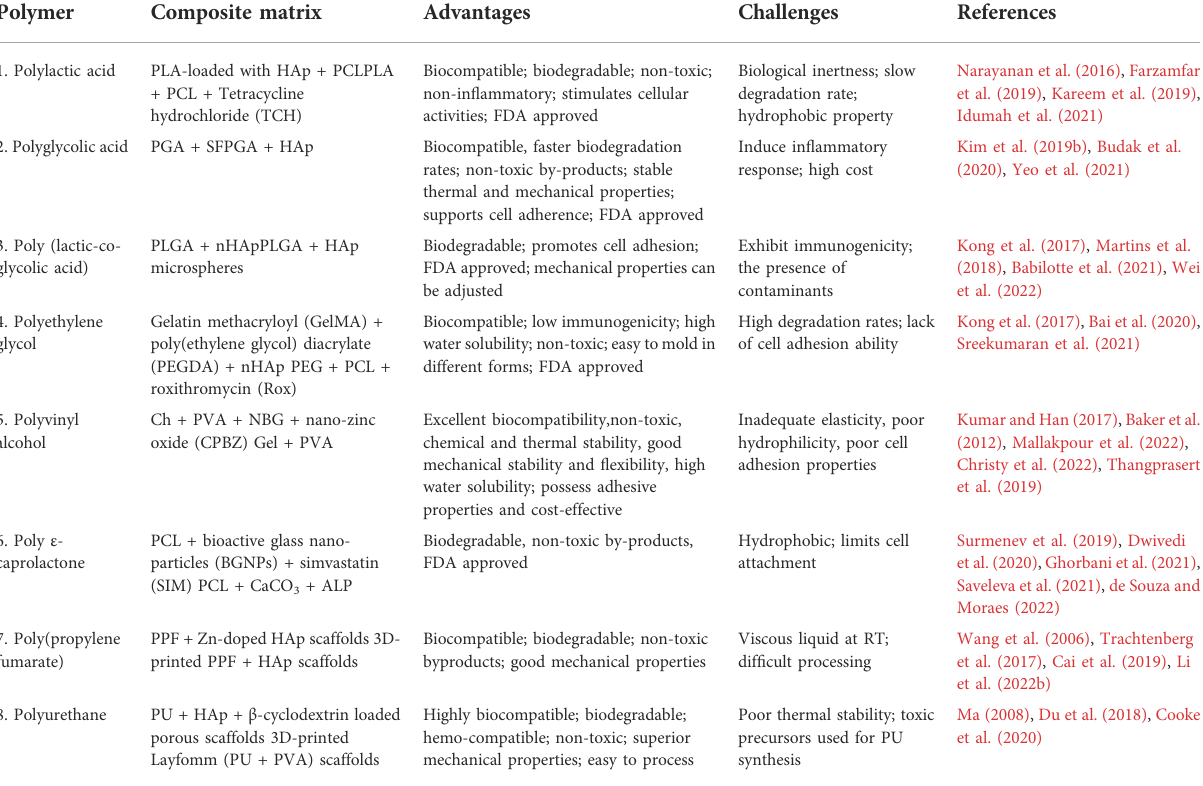
TABLE 2 Advantages and challenges of synthetic polymeric-based composite matrix for